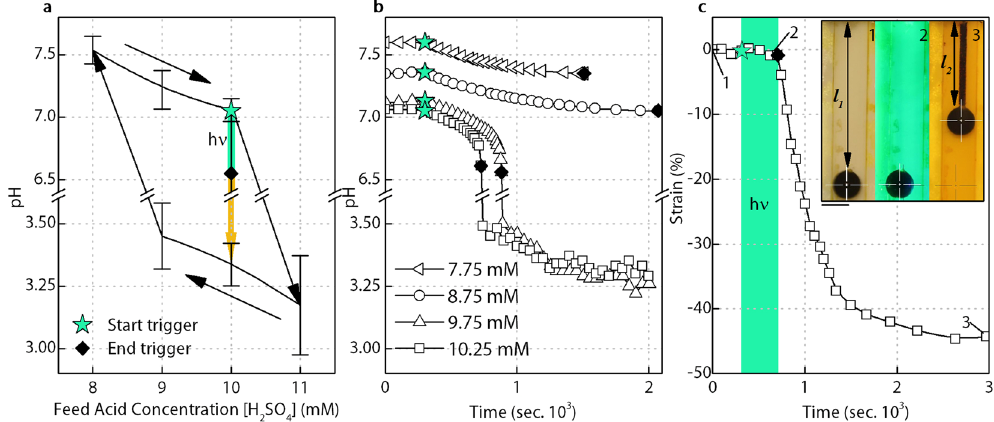
Figure 3. Bistable system response, critical feed acid concentration for successful light-triggering and resulting actuation strain. ( a ) The observed bistability between the high pH kinetic equilibrium and low pH thermodynamic equilibrium states. Error bars ± 1 standard deviation. Illumination near the end of the high pH branch of bistability triggers a jump to the low pH state where actuation occurs. ( b ) Successful triggering only occurs above a critical feed acid concentration (9.5 mM – 9.75 mM), as shown for illumination of systems with feed acid concentrations ranging from 7.75 mM to 10.25 mM. ( c ) The resulting actuation strain response (44.7%), calculated as the change in hydrogel length normalized to the unstrained, swollen hydrogel length ( l 1 − l 2 )/l 1 × 100, is comparable with that of biological muscle. Photo inset of artificial muscle actuation states, black sphere adhered to hydrogel and used for tracking (1) prior to illumination, the hydrogel of extended length l 1 is completely transparent (2) at the end of illumination the hydrogel still has not contracted (3) at the end of actuation it has now actuated to length l 2 . Scale bar 5 mm. The clear swollen hydrogel only becomes visible through the accumulation of iodine after triggering. All results with 12 mm long, 1 mm diameter (unswollen dimensions) micro-porous hydrogel in place (actuation blocking stress of approximately 23